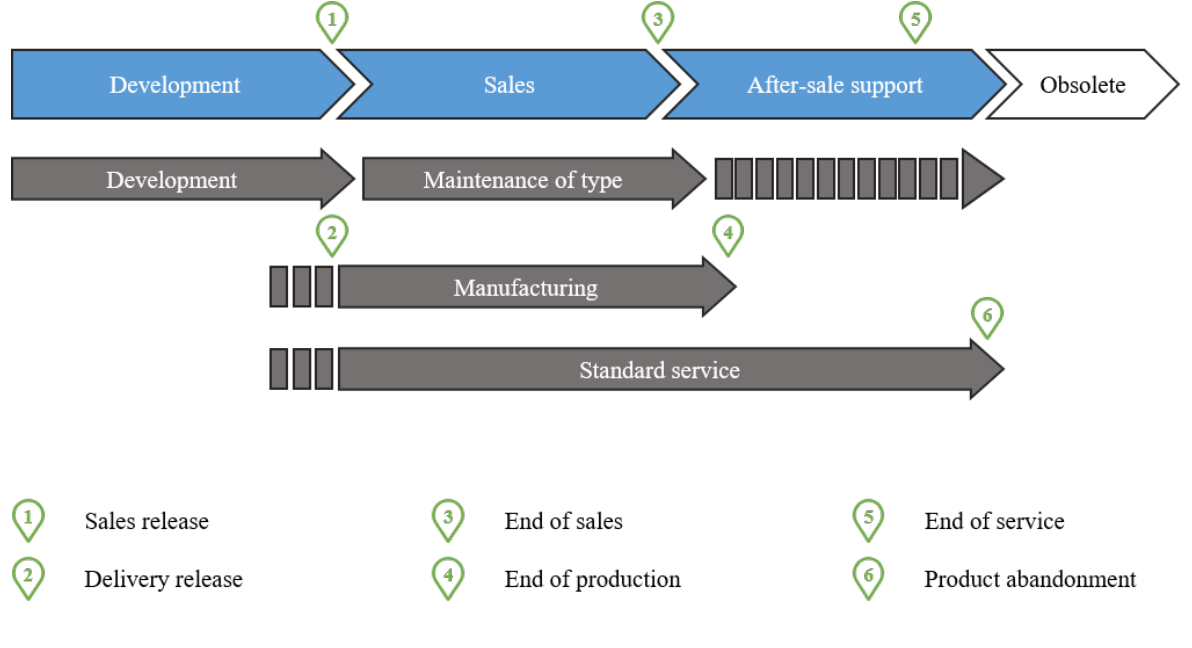
Figure 2. Generic life-cycle model adapted from